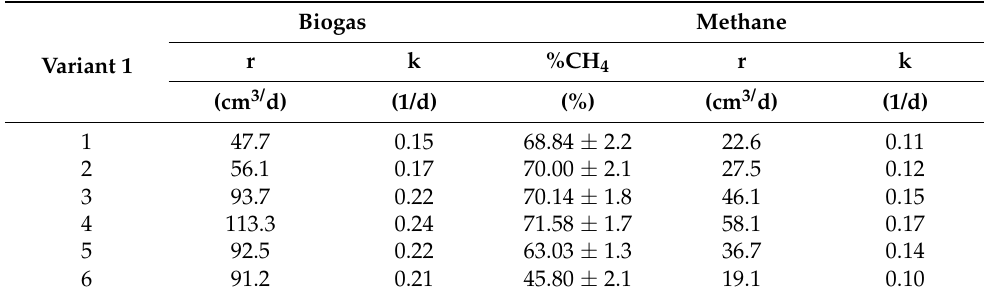
Table 2. Rates of biogas and methane production processes (r), reaction rate constants (k), and methane